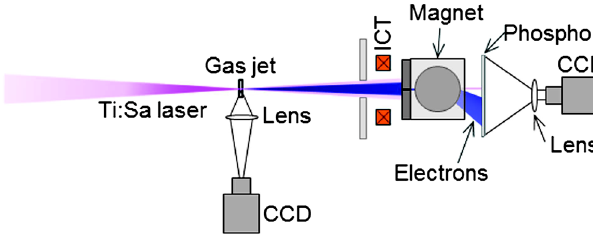
FIG. 1. A schematic diagram of the experimental setup for electron